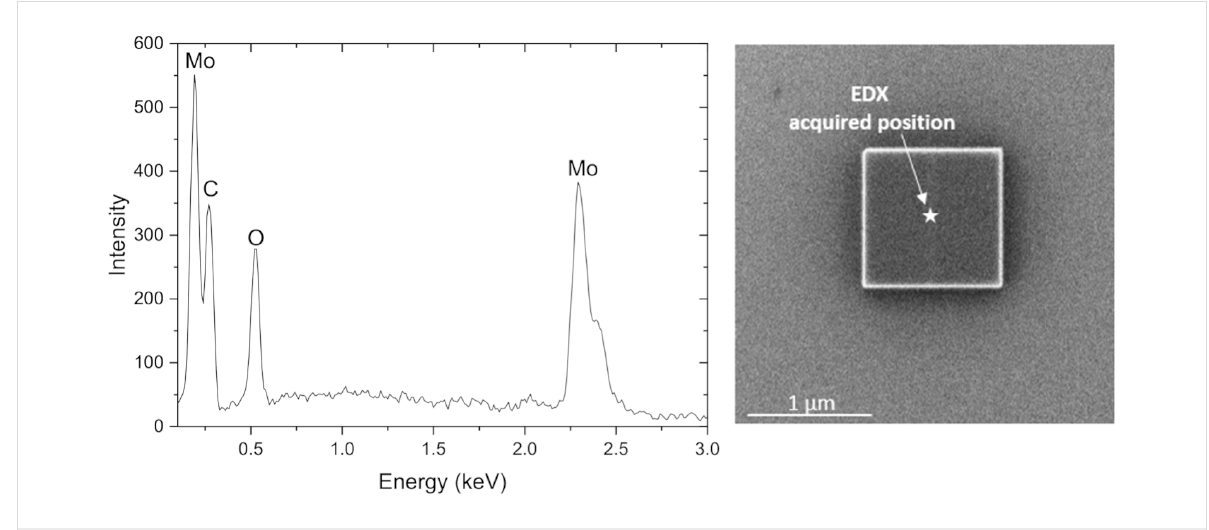
Figure 4: Left: EDX spectrum. Right: SEM image of FEBID pad (1 μ m 2 ) Mo(CO) 6 .